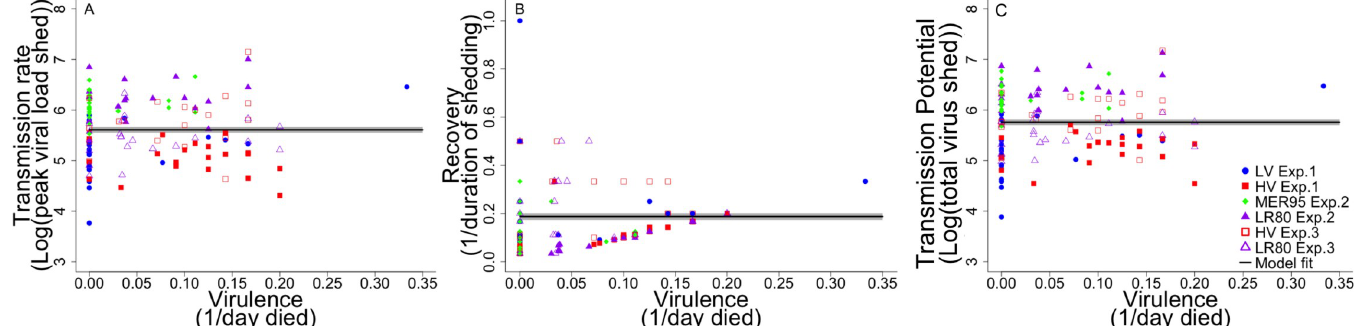
Fig 5. Association between virulence and fitness. Panels show association between (A) transmission rate (peak viral load shed [log10(virus RNA copies/ml H 2 0)]), (B) recovery rate (1/duration of shedding (days)) and (C) total transmission potential (total virus shed [log10(virus RNA copies/ml H 2 0)]), with virulence (1/day fish died). Each data point represents an individual fish infected with a given IHNV genotype in a given experiment (see in figure legend). Only fish exposed to a single virus genotype, which shed detectable virus, are shown. Mixed infections are excluded due to potential confounding effects of genotype interactions on virulence. The solid line represents the best fit ((A) Y = 5.607+/-0.057, (B) Y = 0.187 +/- 0.014, (C)Y = 5. 758 +/-0.056) to the data +/- 1 standard error (SE) (grey area). The line demonstrates a uniform, non-significant association in all cases. As such, virulence explained none of the variance in the viral fitness parameters on an individual fish basis.